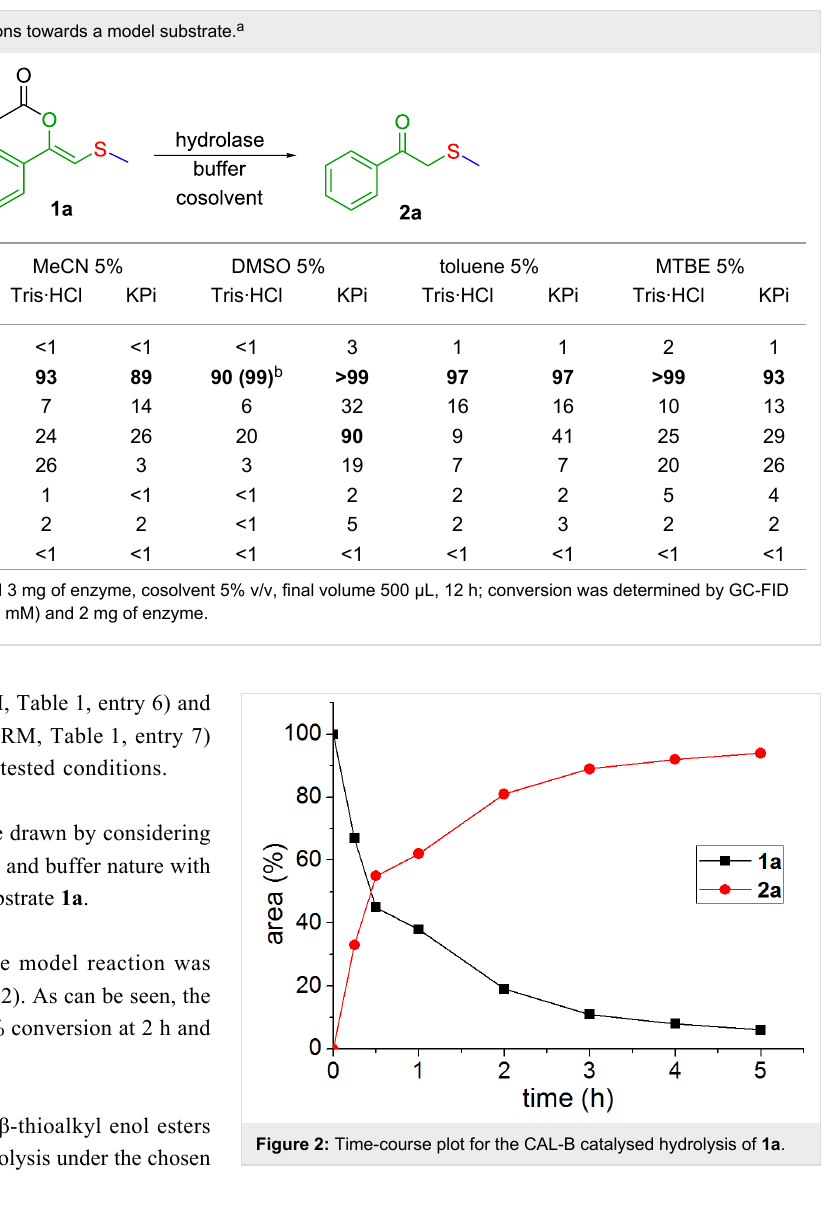
accepted as substrate (Table 2, entry 18). The same results were obtained when an ester moiety was pending at α -position ( 1s , Table 2, entry